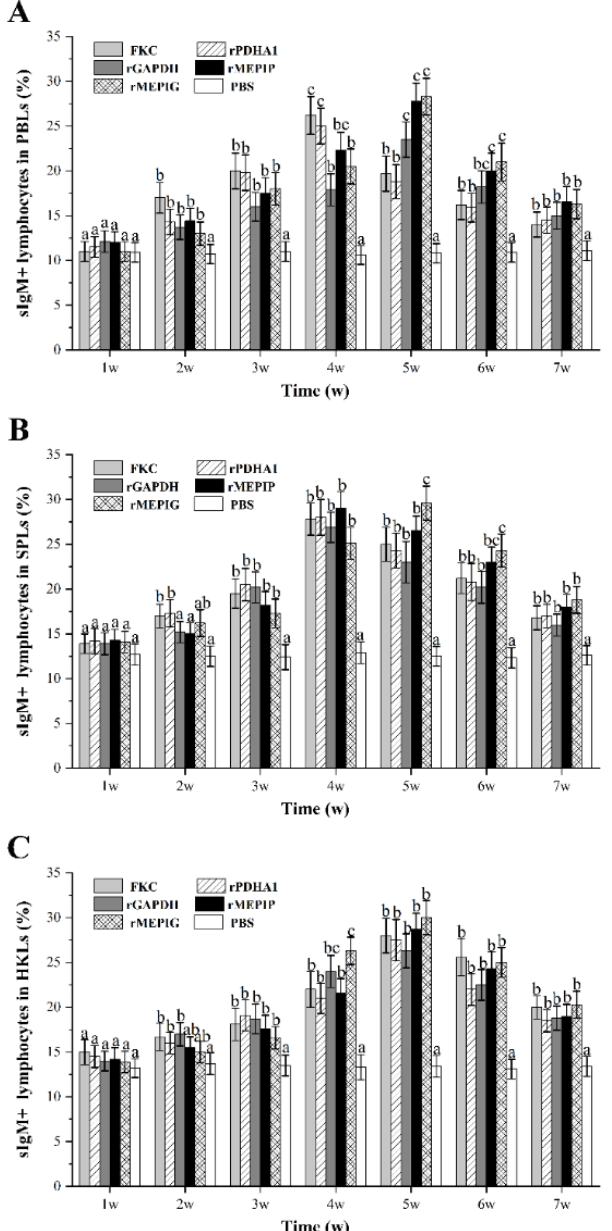
Figure 6. Variations of sIgM + lymphocyte percentages in PBLs, SPLs and HKLs of flounder after FKC, rPDHA1, rGAPDH, rMEPIP, rMEPIG and PBS immunization. ( A ) Variations of sIgM + lymphocytes in peripheral blood. ( B ) Variations of sIgM + lymphocytes in spleen. ( C ) Variations of sIgM + lymphocytes in head kidney. Values are shown as means ± SD of three fish. Different letters above the bar represent the statistical significance ( p < 0.05) compared to each other at the same time point.